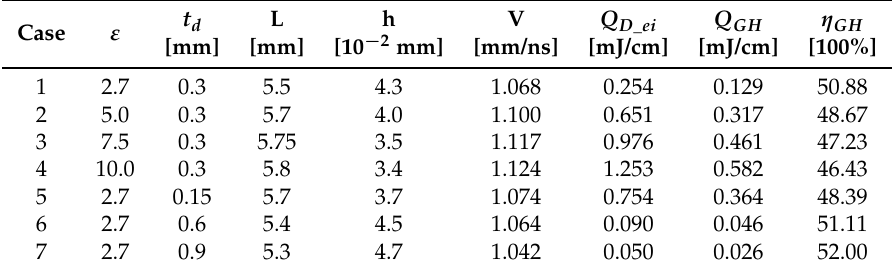
Table 2. List of the simulation cases and the results. L , h and V are the maximum streamer length, the plasma sheath thickness and the streamer propagation speed, respectively. Q D _ ei , Q GH , and η GH are the total discharge energy, the gas heating, and the gas-heating efficiency of a pulse,